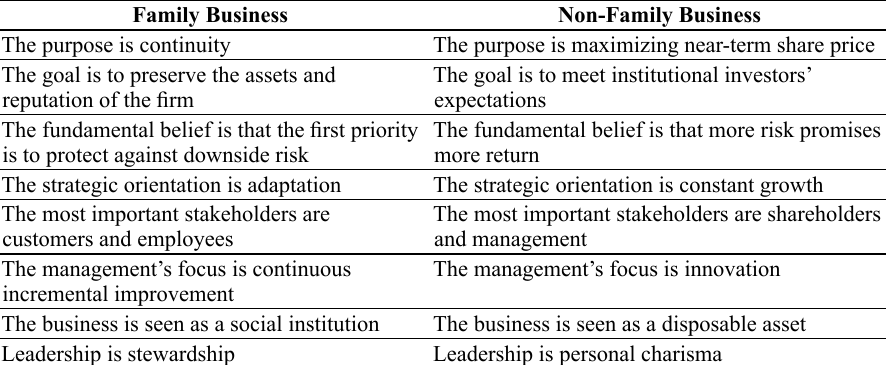
Table 1: Comparison between Family Business and Non-Family Business Family